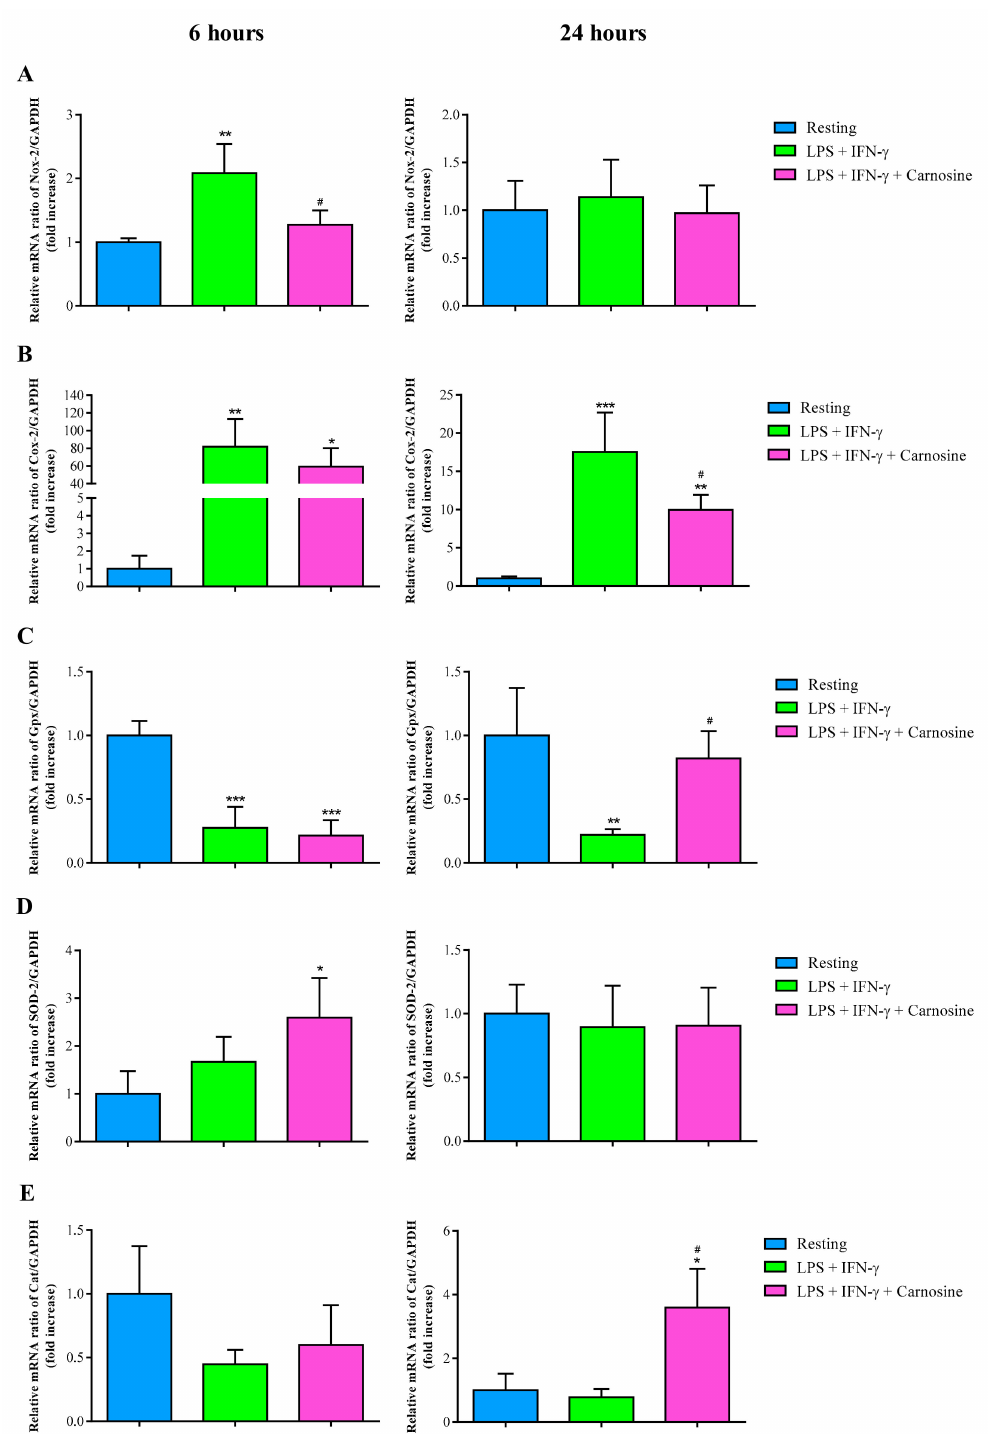
Figure 5. Measurement of ( A ) Nox-2, ( B ) Cox-2, ( C ) Gpx1, ( D ) SOD-2, and ( E ) Cat mRNA expression levels (qRT-PCR) in resting (control) RAW 264.7 macrophages and in macrophages stimulated with LPS (100 ng / mL) + IFN- γ (600 U / mL), in the absence or in the presence of carnosine (20 mM). The abundance of each mRNA of interest was expressed relatively to the abundance of GAPDH-mRNA. Values are means ± SD of three to four independent experiments. * p < 0.05 vs. resting; ** p < 0.01 vs. resting; *** p < 0.001 vs. resting; # p < 0.05 vs. LPS + IFN- γ